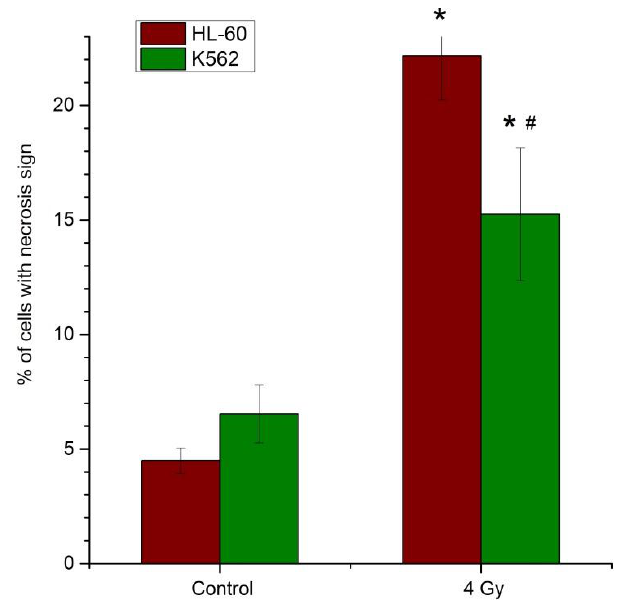
Figure 1. Percentage of cells with signs of necrosis in control group and after radiation exposure at the dose of 4 Gy in the HL-60 and K562 cell lines. *—Statistically significant difference between control and irradiated cells, p < 0.05; #—Statistically significant difference between the HL-60 and K562 cell lines, p < 0.05.